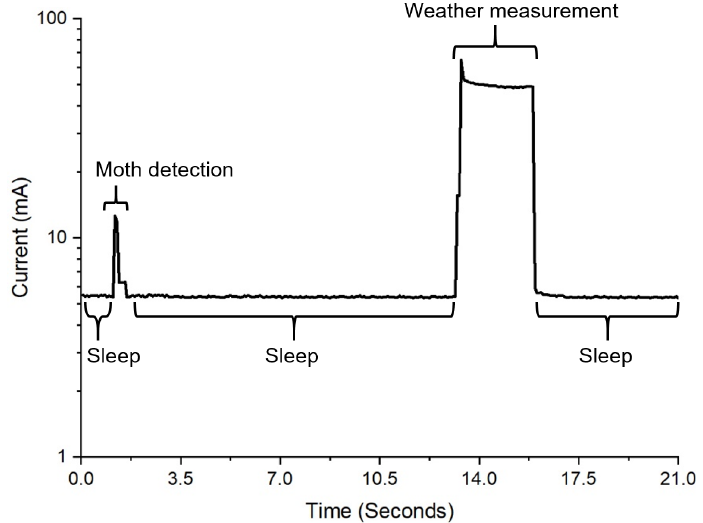
Figure 12. A graph of the amount of current used by the system in its moth detection